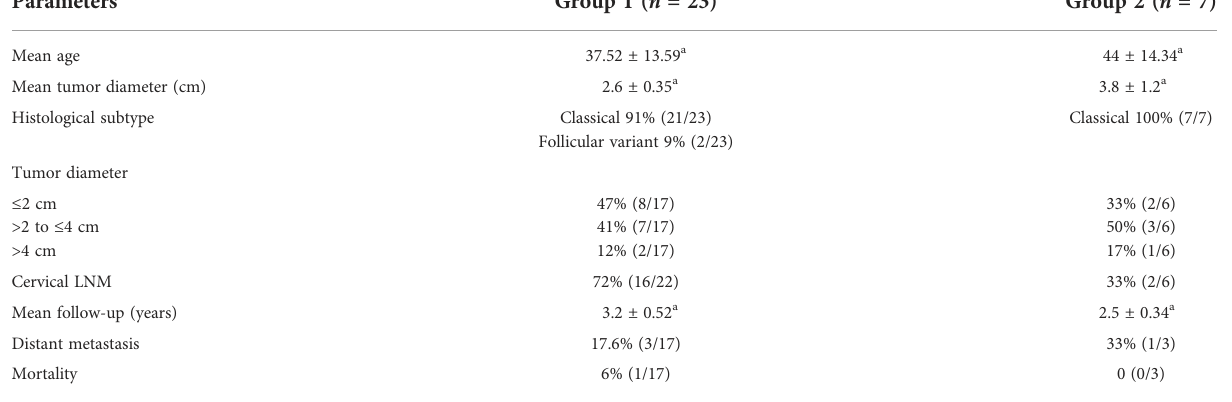
TABLE 1 Clinical details of